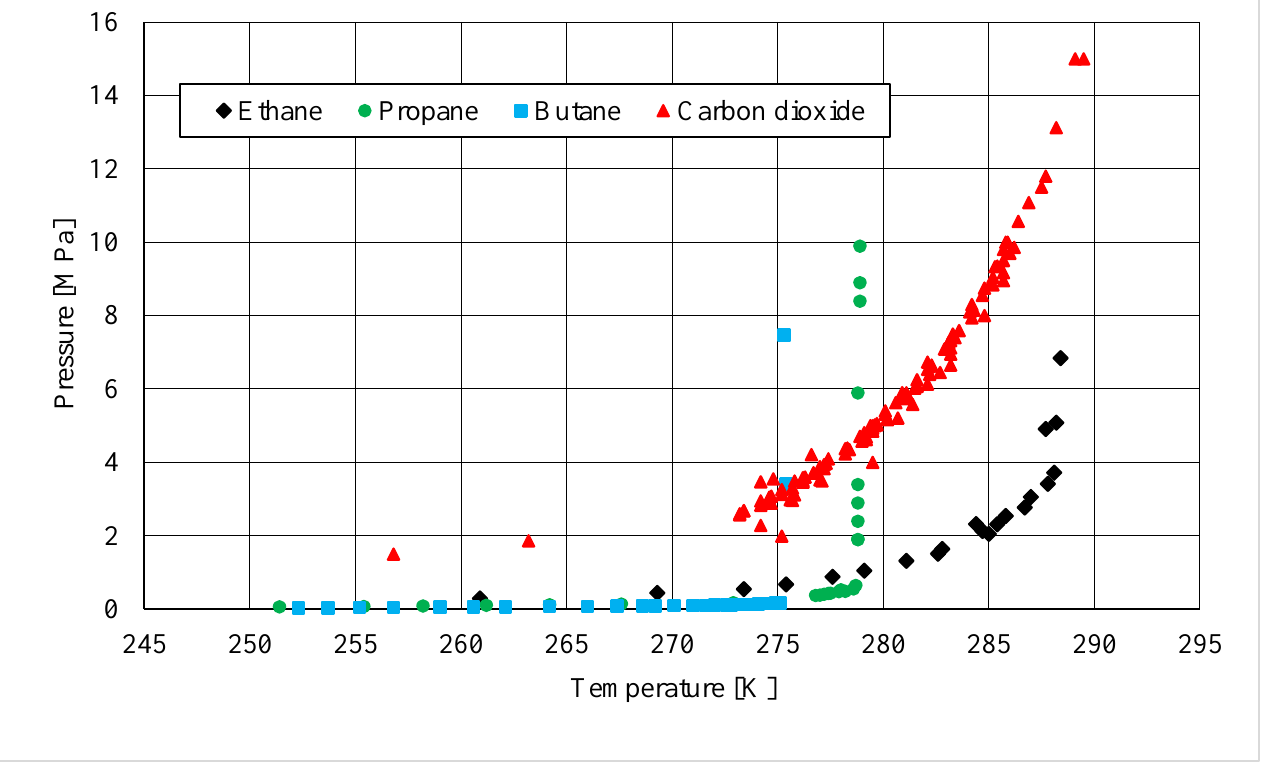
Figure 4. Phase equilibrium boundary conditions for single-guest hydrates containing carbon dioxide or a small-chain hydrocarbon [82 – 86].